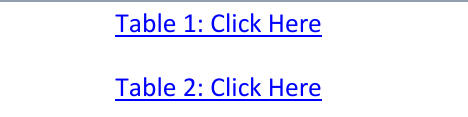
Table 1: Click Here Table 2: Click